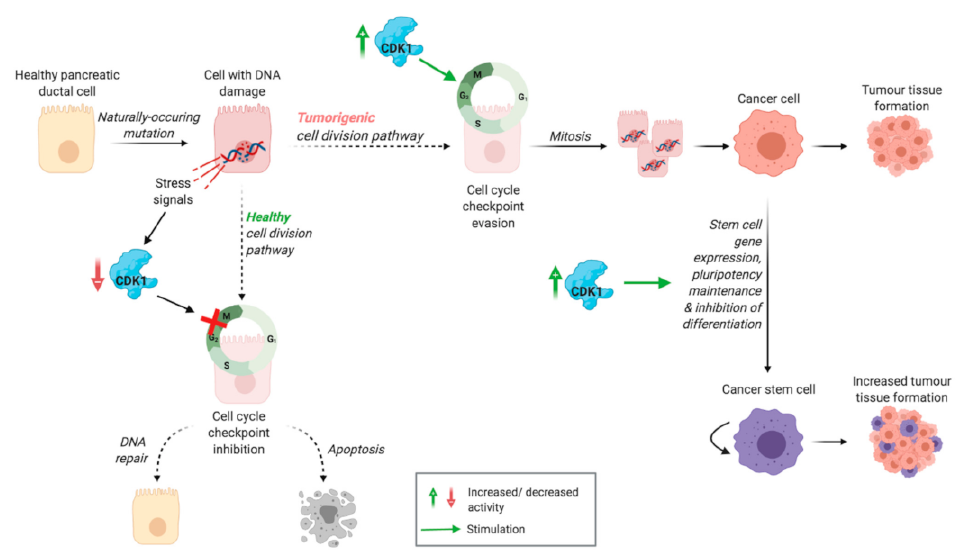
Figure 2. Proposed tumorigenic activity of CDK1. Healthy cell division pathway: stress signals induced by DNA damage lead to inactivation of CDK, inhibiting the cell cycle checkpoint. This results in DNA repair or apoptosis, preventing replication of cells with DNA damage. Tumorigenic cell division pathway: CDK1 overexpression induces cell cycle checkpoint evasion, leading to proliferation of cells with DNA damage, which can eventually lead to tumour tissue formation. Pluripotency maintenance and stem cell gene expression, stimulated by CDK1 activity, contribute to the development of cancer stem cells, increasing tumour tissue